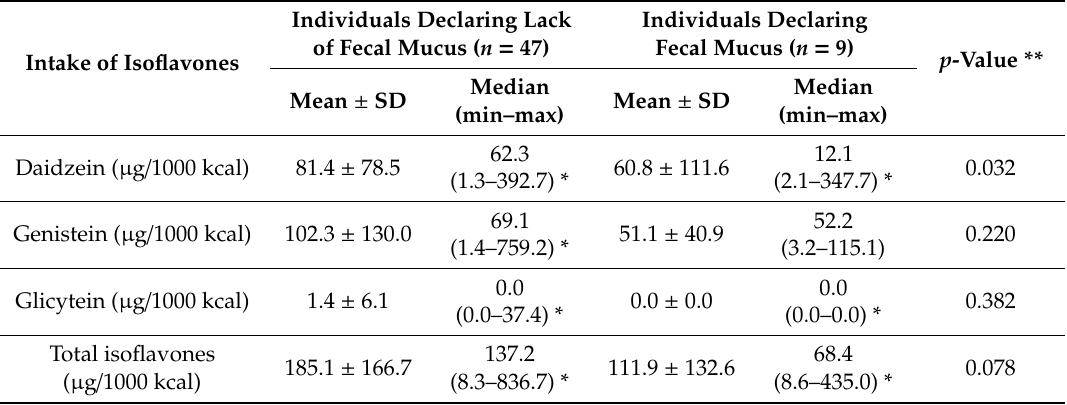
Table 5. The isoflavone intakes per 1000 kcal in groups of individuals with ulcerative colitis declaring either lack or presence of fecal